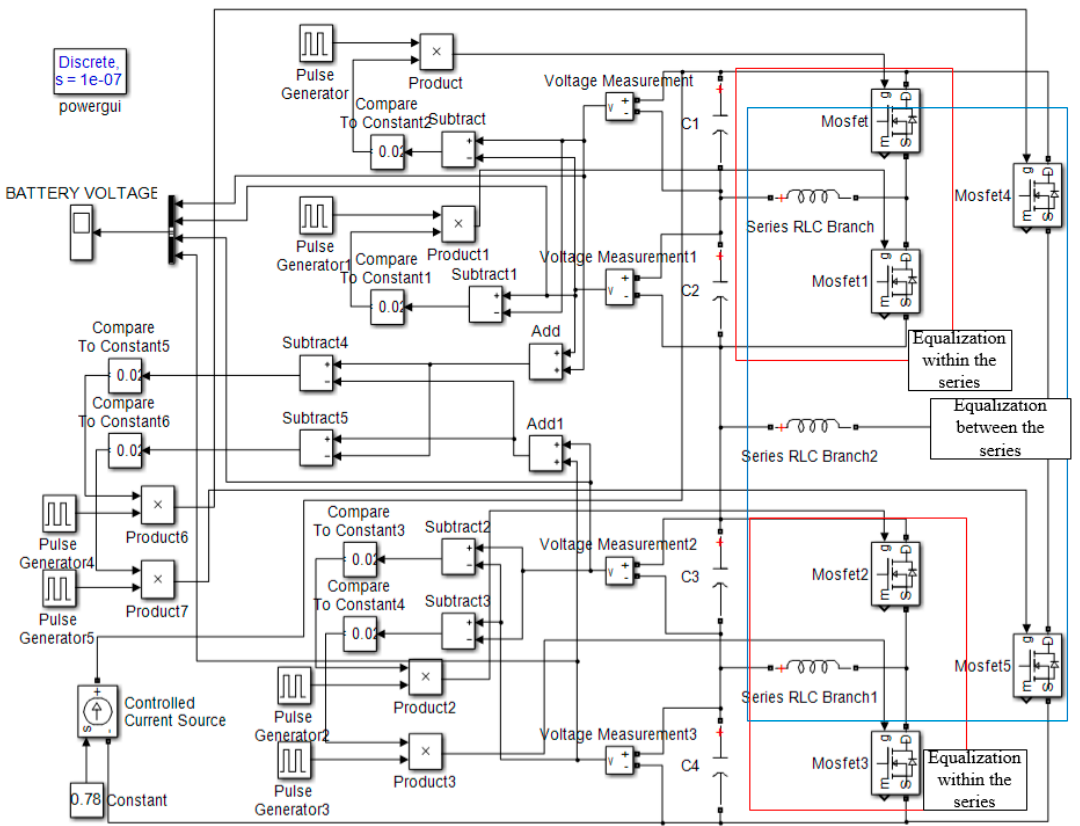
Figure 9. Active equalization circuit simulation structure.